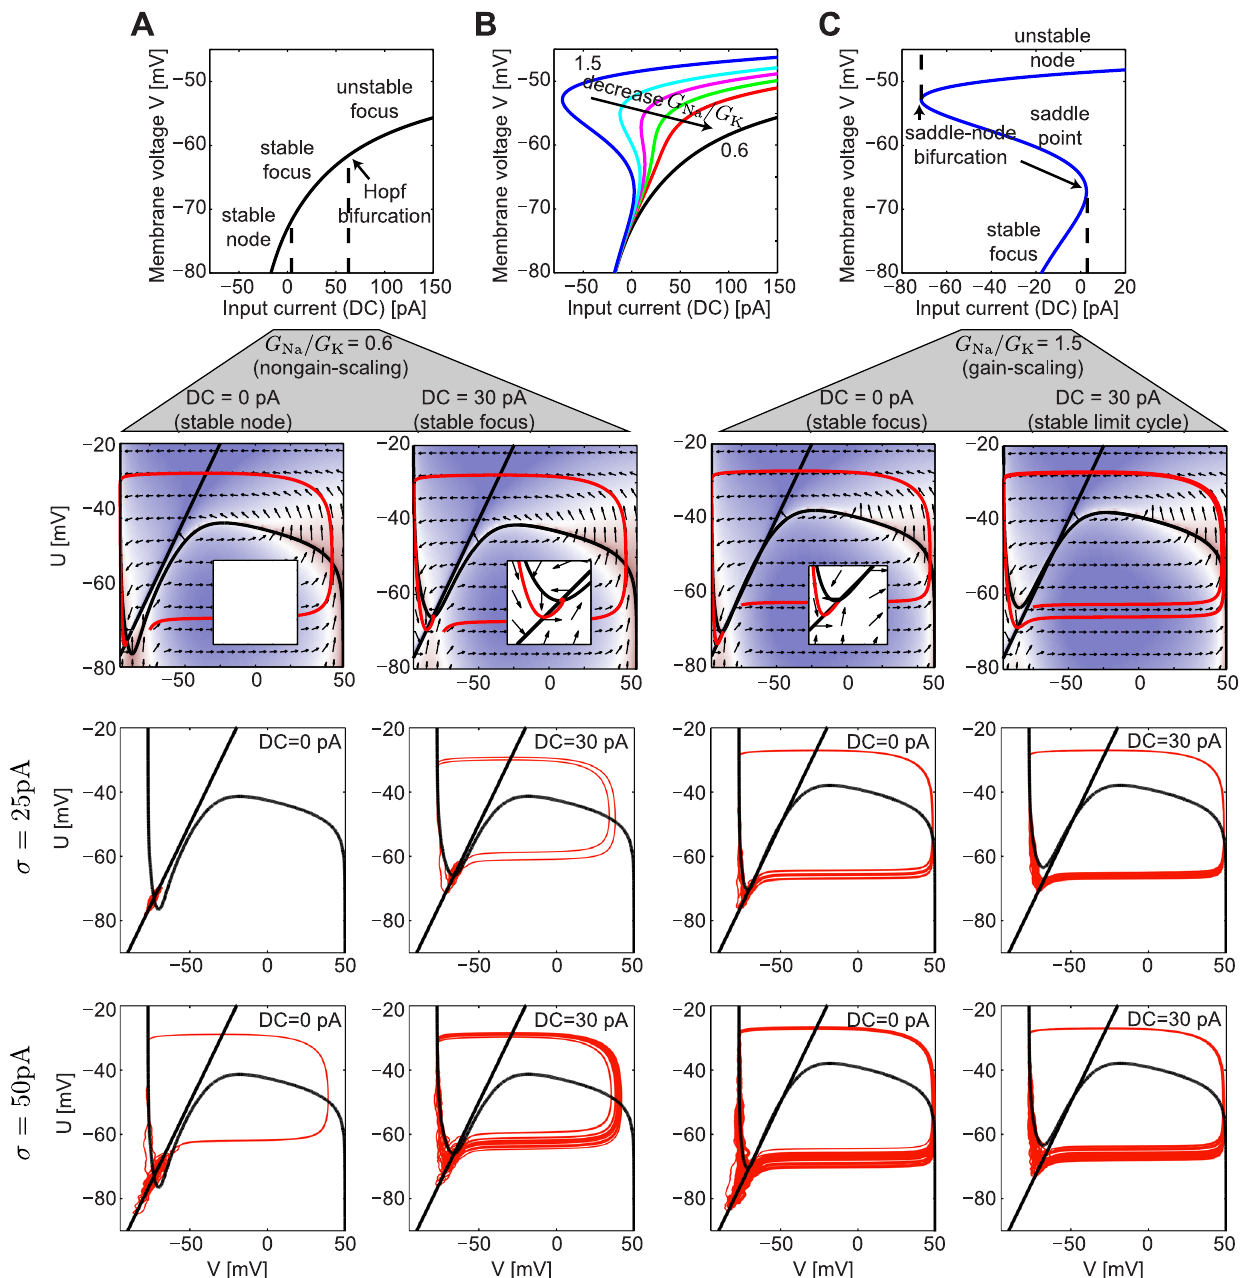
Figure 8. Analysis of the reduced Mainen model. A . Top: Fixed points and their stability for the dynamics of a NGS neuron with G K ~ 1000 pS/ m m 2 and G Na ~ 600 pS/ m m 2 ( G Na = G K ~ 0 : 6 ) as a function of the input current DC. Bottom: The phase planes showing the nullclines (black) and their intersection points (fixed points) together with the flow lines indicated by the arrows. A single trajectory is shown in red. The inset shows a zoomed portion of the phase plane near the fixed point. Below we show trajectories for two values of s and two DC values. B . The fixed points for different ratios G Na = G K , while keeping G K ~ 1000 pS/ m m 2 and varying G Na , as a function of the DC. C . Same as A but for a GS neuron with G K ~ 1000 pS/ m m 2 and G Na ~ 1500 pS/ m m 2 ( G Na = G K ~ 1 : 5 ). Note that the abscissa has been scaled from A and B.